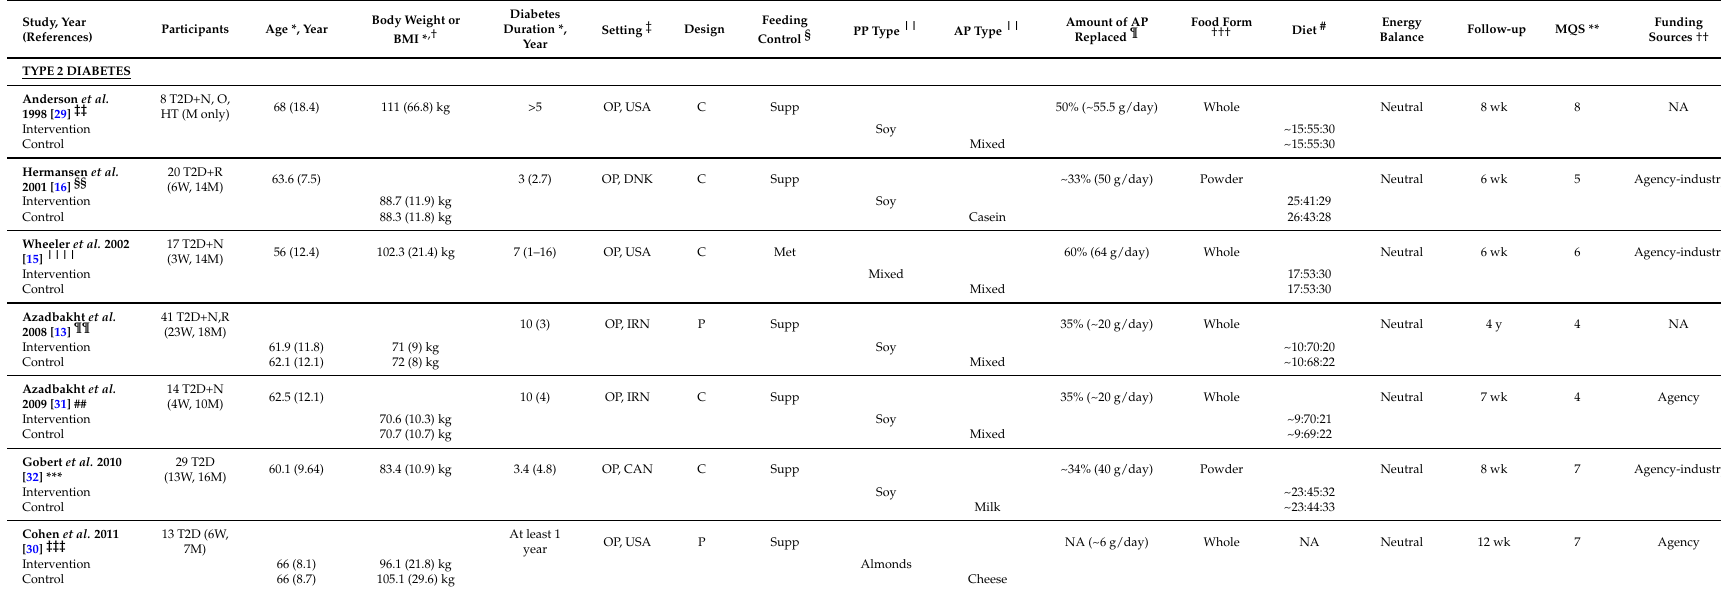
Table 1. Characteristics of included randomized controlled